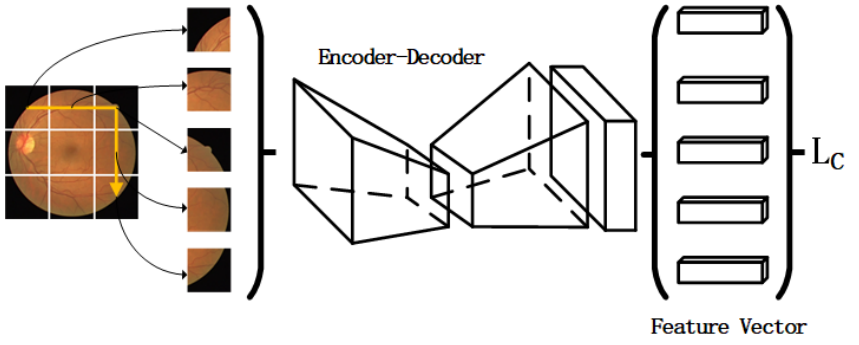
Figure 3. Vector prediction